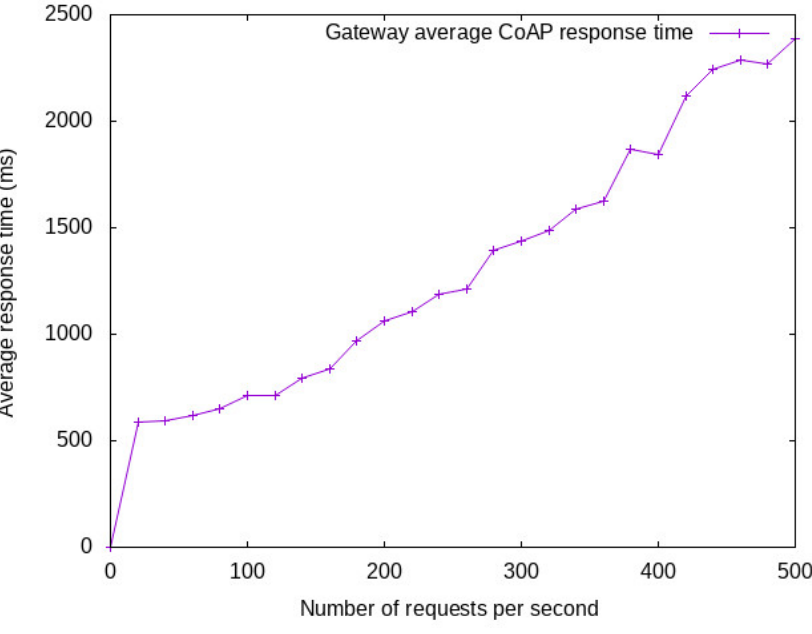
Figure 11. Gateway average response time for concurrent CoAP